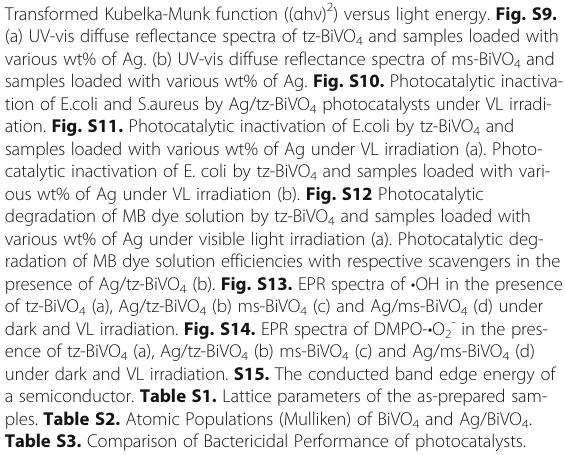
ples. Table S2. Atomic Populations (Mulliken) of BiVO 4 and Ag/BiVO 4 . Table S3. Comparison of Bactericidal Performance of photocatalysts. Abbreviations SEM: Scanning electron microscopy; TEM: Transmission electron microscopy; XRD: X-ray power diffraction; XPS: X-ray photoelectron